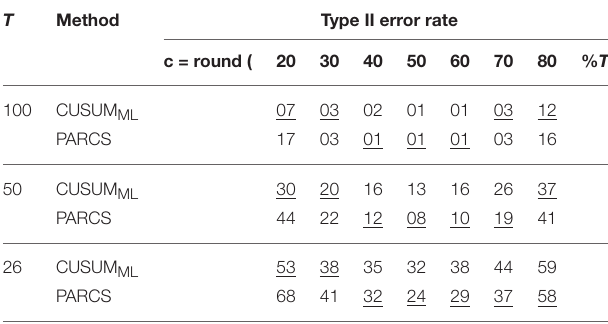
Bai, 1997) for univariate data with white Gaussian noise. TABLE 1 | Type II error rates in PARCS compared to CUSUM ML for different lengths of the time series; underline, method with higher detection rate; nominal α level, 0.05 for both